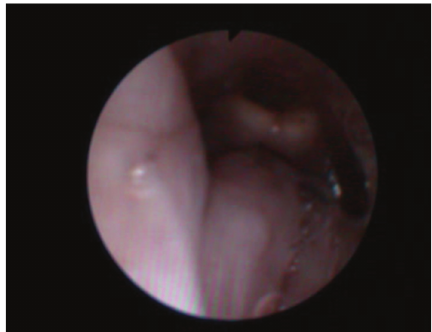
Figure 1: Video of the fibreoptic intubation illustrating swollen base of tongue and swollen epiglottis.